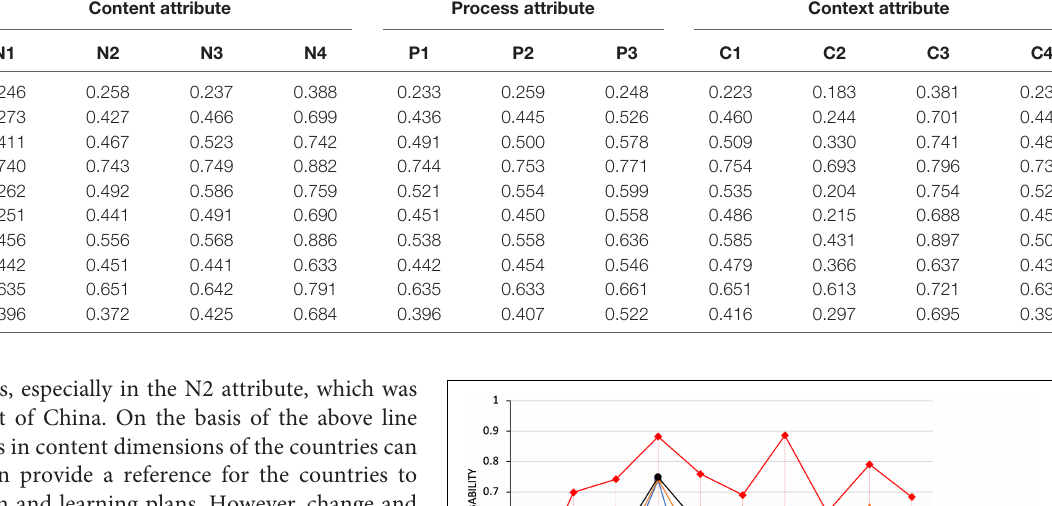
TABLE 4 | Proportional distribution of 11 attributes in 10 countries. Country Content attribute Process attribute